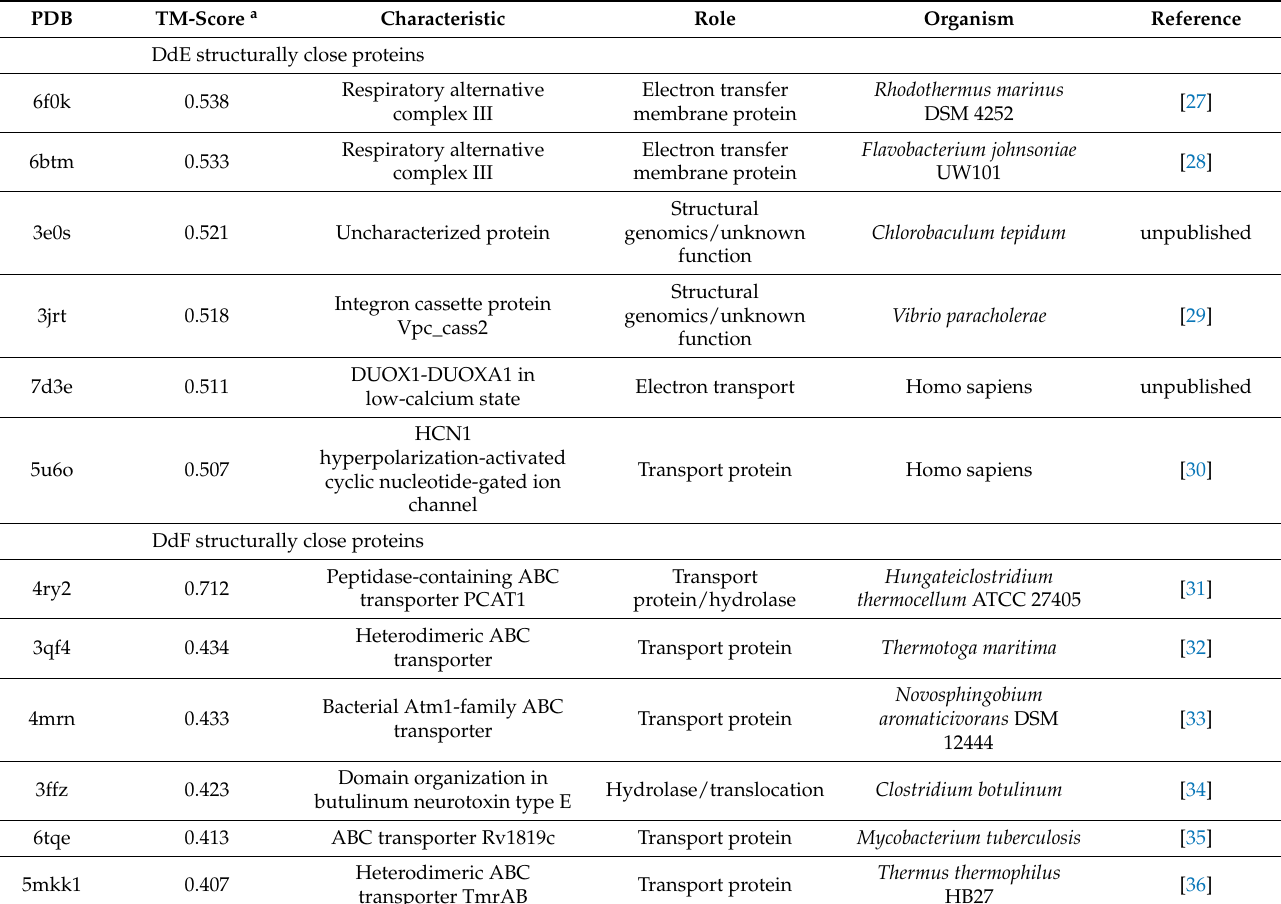
Table 3. Proteins structurally close to DdE and DdF obtained with the I-TASSER